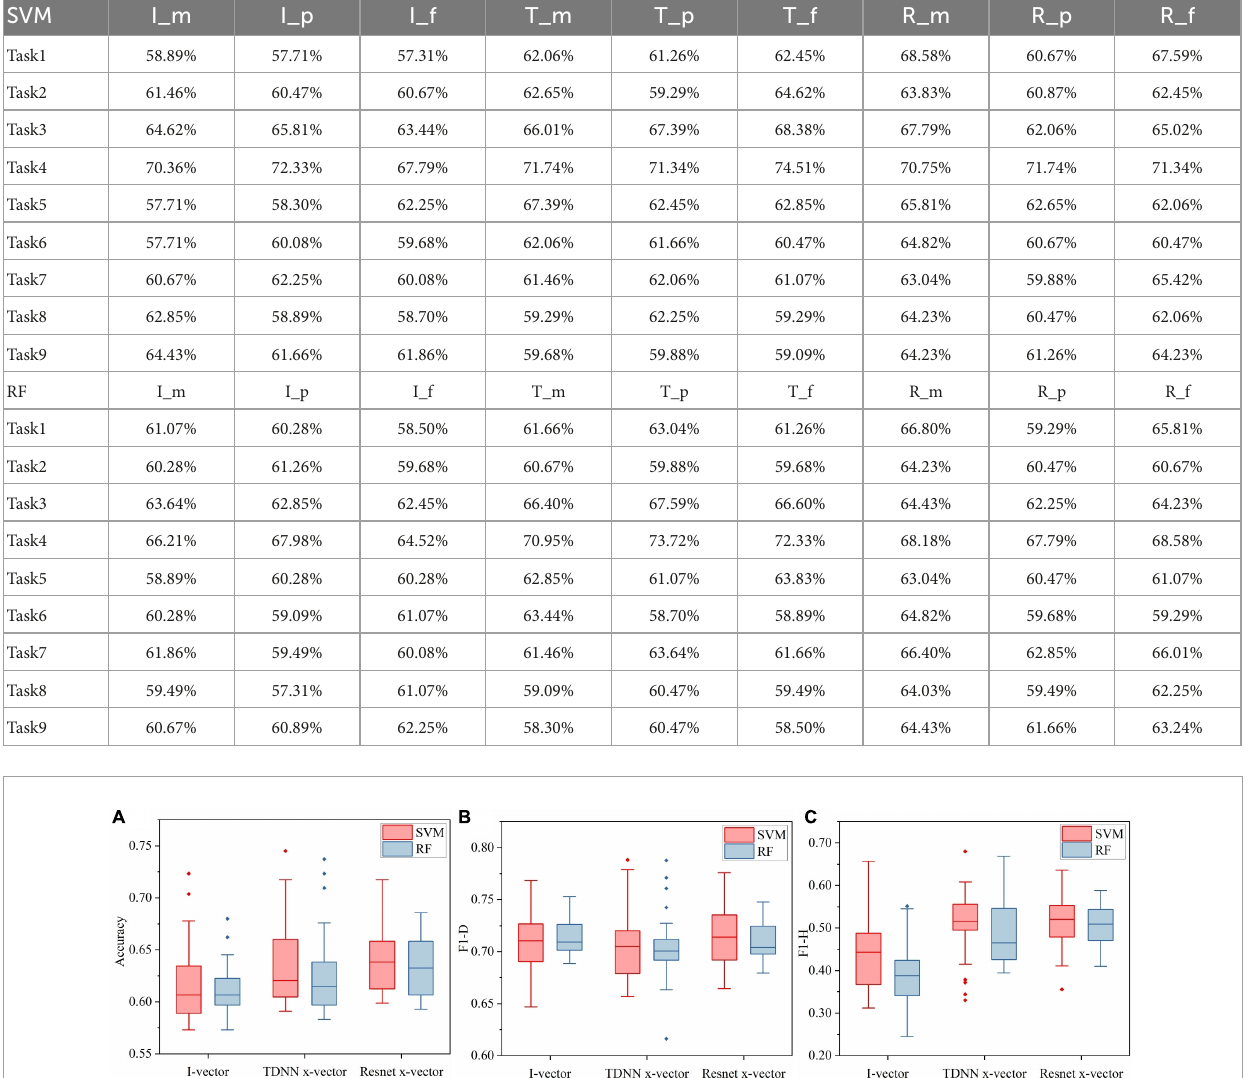
TABLE 5 Accuracy comparison of nine speaker embeddings under nine speech tasks using SVM or RF classifier.